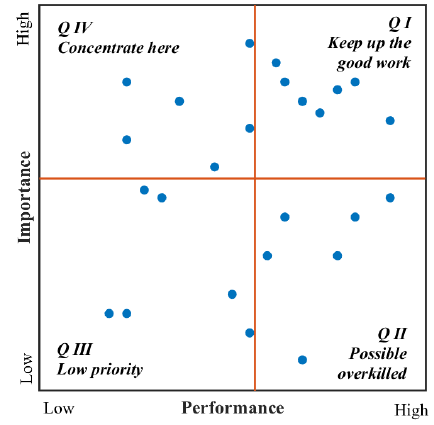
Figure 2. An example of IPA plot.